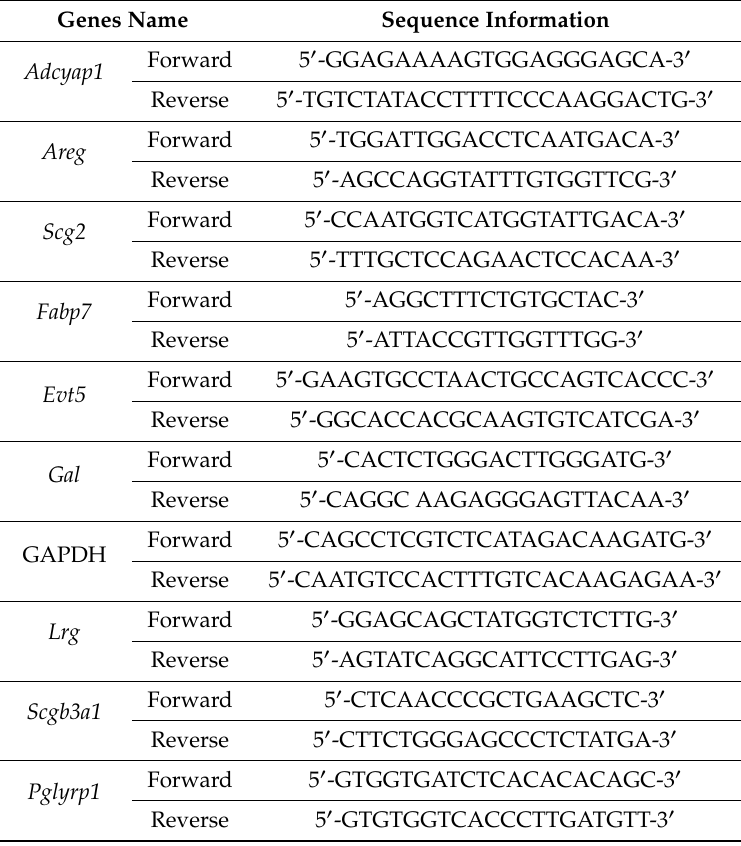
Table 4. Primers sequences